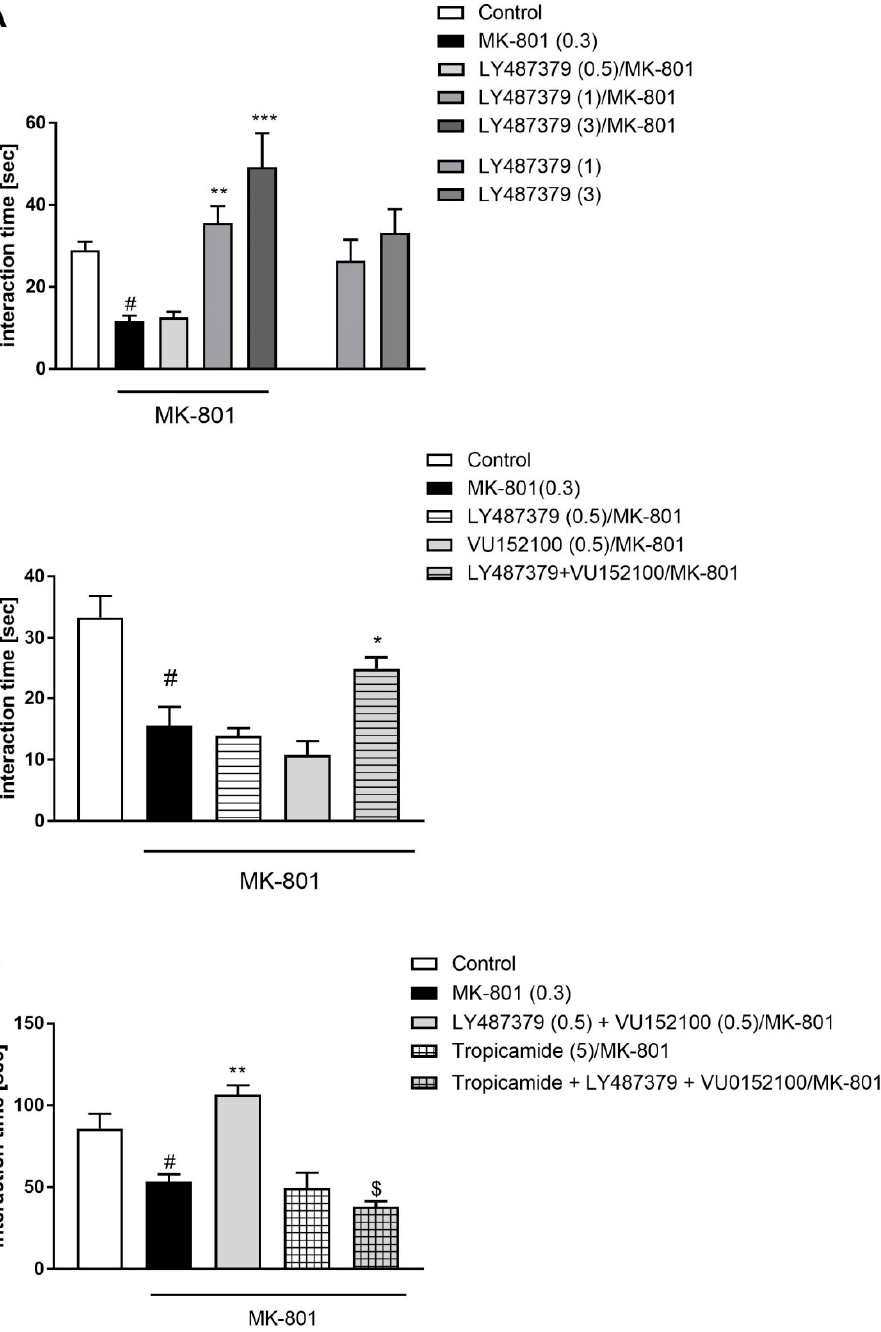
Figure 5. Social interaction test in mice. Effectivity of LY487379 ( A ), combined administration of sub-effective doses of LY487379 and VU152100 ( B ), and the blockade of the combination’s effect by M 4 receptor antagonist Tropicamide ( C ). Compounds and MK-801 were administered acutely as shown on Figure 1. The investigated doses are indicated in parentheses. Bars represent the means ± SEM. N = 8–10/group. # p < 0.001 versus the control group; * p < 0.05, ** p < 0.01 and *** p < 0.001 versus the MK-801-treated group; $ p < 0.0001 versus the LY487379 + VU152100 group. 2.3.2. Effectivity of Prolonged Administration of Compounds in Animals Acutely Treated with MK- 801.